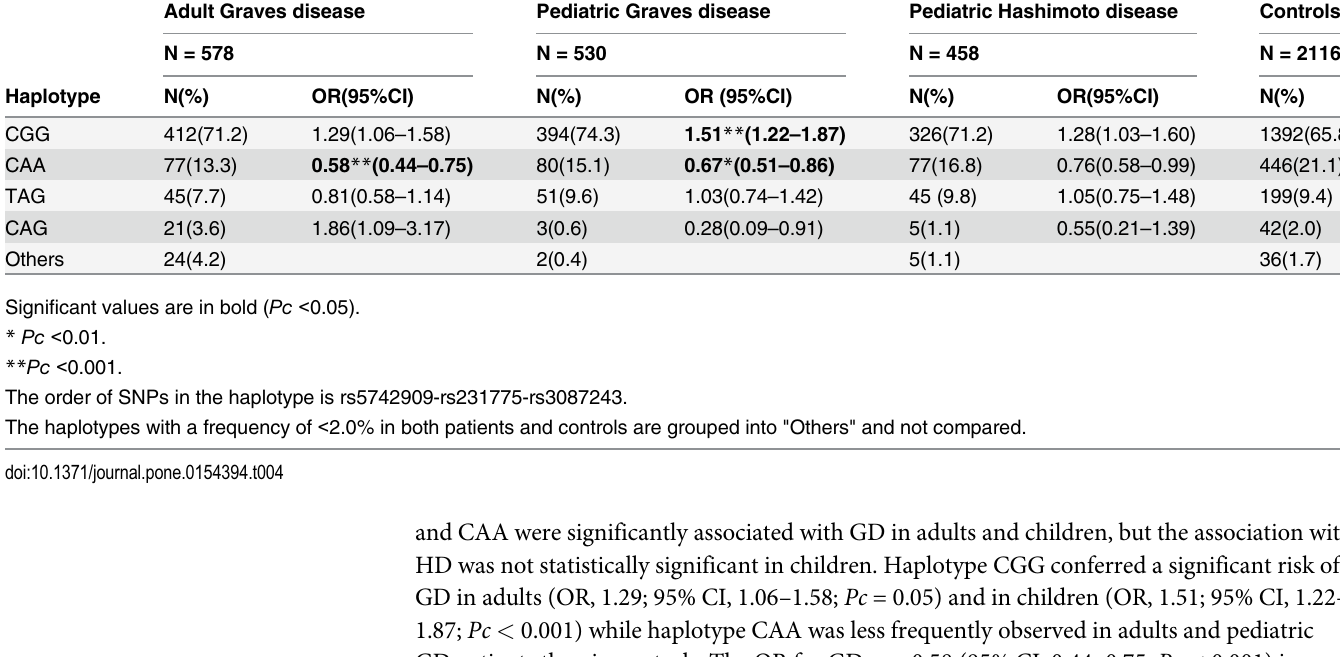
Table 4. Frequency of haplotypes of the CTLA4 gene in adult Graves disease, pediatric Graves disease, Hashimoto disease patients and controls. Adult Graves